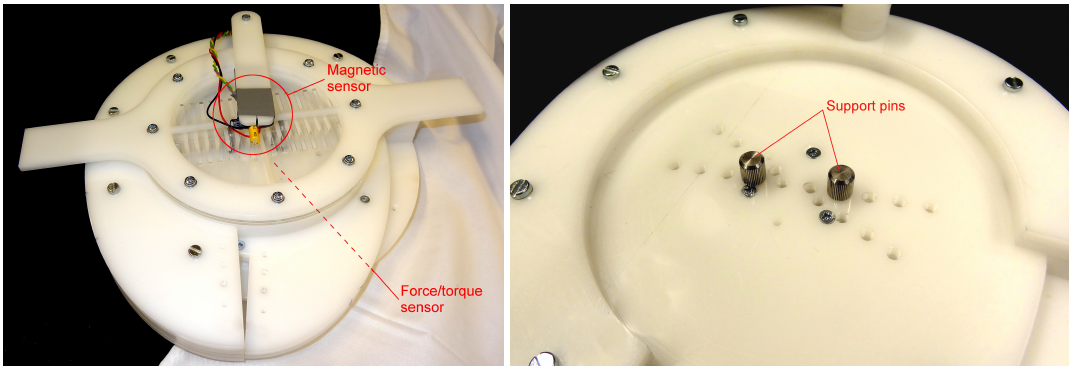
Figure 13. The experimental setup used to measure the stiffness characteristic of the variable stiffness mechanism. A magnetic sensor is placed over the device to measure the output rotation, while a force/torque sensor is placed under the device to measure the applied torque. The support pins can be placed at predefined